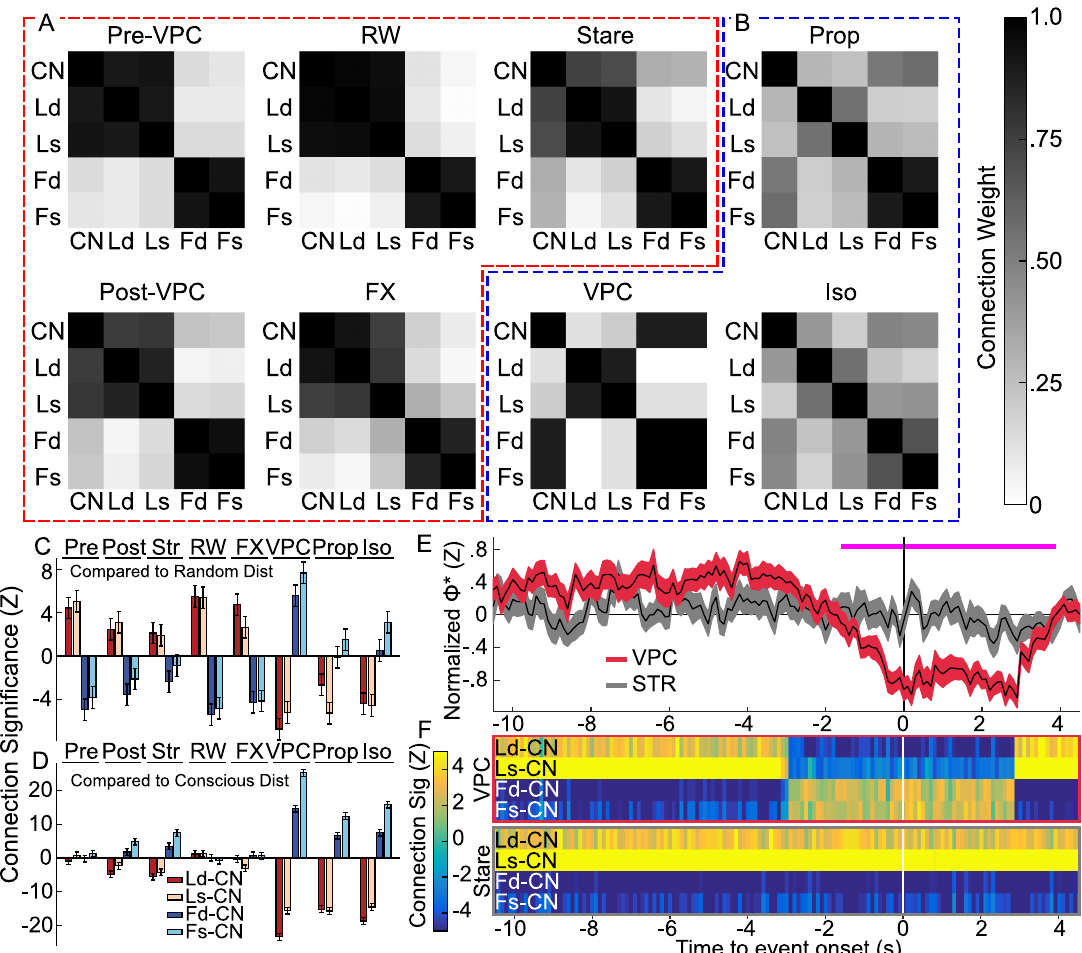
Fig 6. MIP changes reflect switches in parieto-striatal association indicative of consciousness. A , B , Probability (connection weight) of each brain area associating with any other on the same side of the MIP for states assumed to be ( A ) conscious (pre-VPC, post-VPC, resting wake (RW), fixation task (FX) and control stares) or ( B ) less conscious (VPC, propofol (Prop), or isoflurane (Iso)). C , D , Results (Z statistics ± SD of the null distribution) of the permutation test comparing cortico-striatal MIP associations under the null hypotheses that ( C ) MIP types occur randomly, or ( D ) MIP types reflect the same patterns as conscious states (defined by the resting wake and fixation task samples). Both approaches separate more conscious from less conscious states. E , Normalized F � ( ± SE) for VPC and control stares (STR) calculated in 1s sliding windows (.1s steps) and aligned to event onset (black vertical line). Horizontal pink line shows regions of significance for the pairwise t-test across time comparing VPC F � at each sample to the maximum. No significant differences were found in the control stare condition. F , Cortico-striatal significance (Z) based on the sliding window approach in E for VPC and stare conditions. Computations used the same approach as in C, but now for each sample in the sliding window.